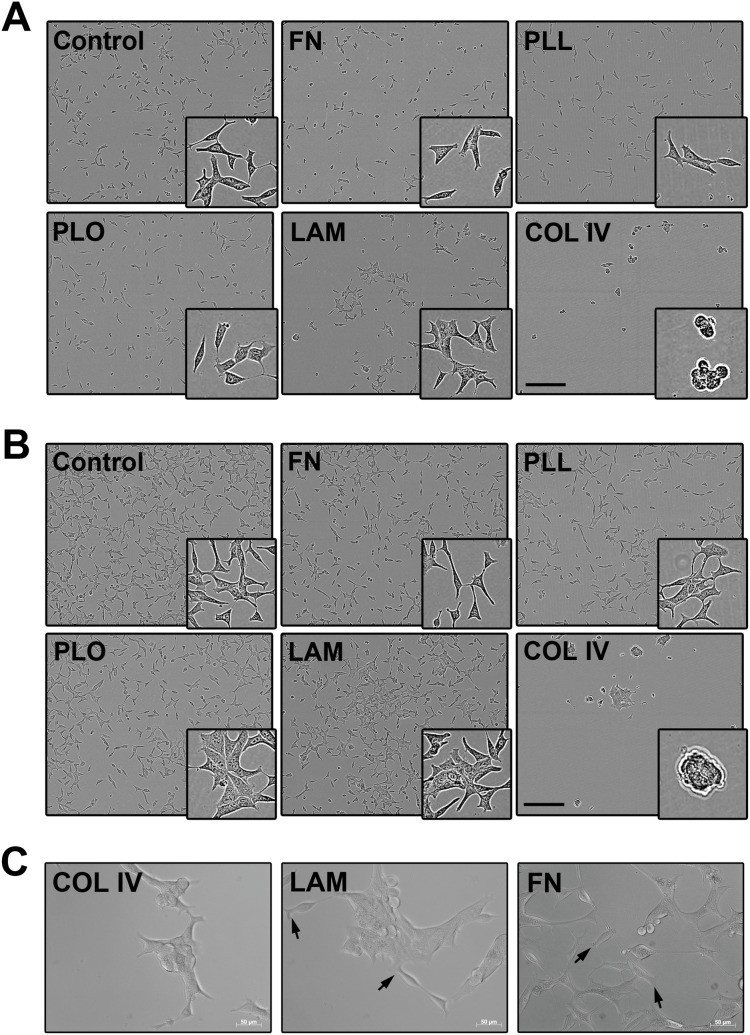
Morphology of LNCaP cells grown on different coated polystyrene well substrates.LNCaP cells imaged after 24 h (A) and 96 h (B) with IncuCyte system, 10×. Scale bar = 300 µm. (C) Snap shots from the 96 h time-lapse microscopy video of LNCaP cells. Arrows indicate lamellipodia of polarized cells. Scale bar = 50 µm (20×, Zeiss Axio Observer).